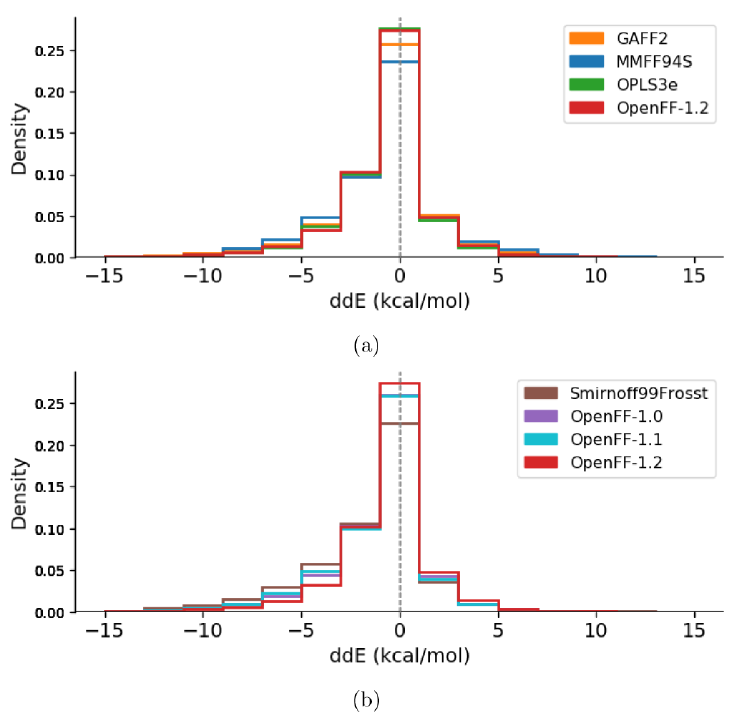
Figure 3. Histograms of the relative conformer energy differences as computed in Equation 2 for each force field relative to QM. Each molecular structure, including different conformers of the same molecule, is counted separately. Since the global minimum molecular structures were set to zero deliberately and add a constant offset to the central bin, they are removed from the counts. A force field having higher agreement with QM would have a higher bin centered at ddE = 0 kcal/mol. ( a ) compares the latest release of all four force field families. ( b ) shows the four histograms belonging to the OpenFF family of force fields. OpenFF-1.0 (purple) and OpenFF-1.1 (light blue) overlap in the central bin. The corresponding graph comparing histograms of all calculated force fields can be found in the Extended data , Figure S.1 93